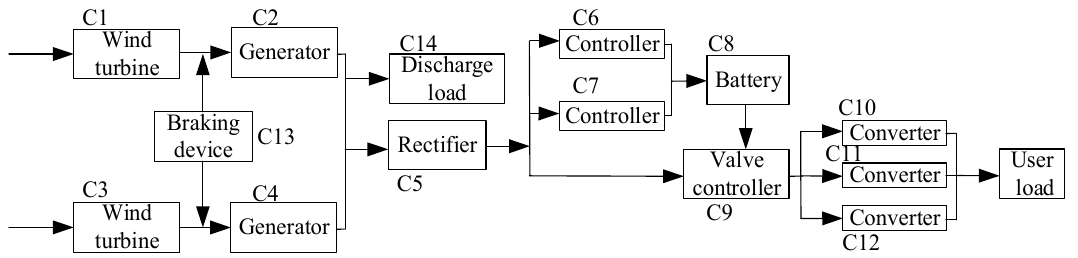
ff -grid wind power Figure 2. Detailed flow diagram of the off-grid wind power system. Figure 2. Detailed flow diagram of the o Figure 2. Detailed flow diagram of the off-grid wind power system.